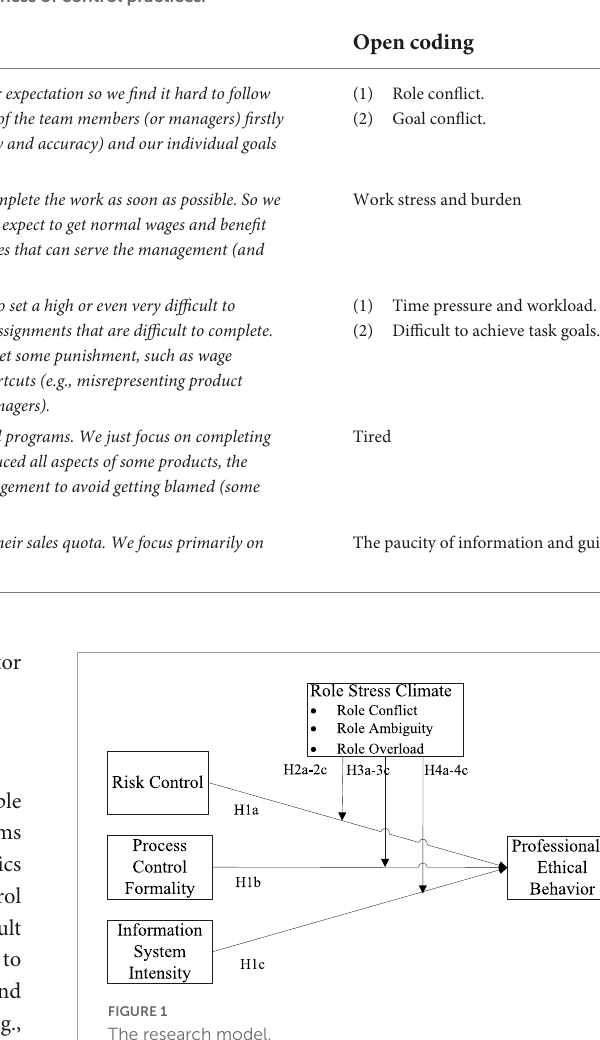
FIGURE1 The research